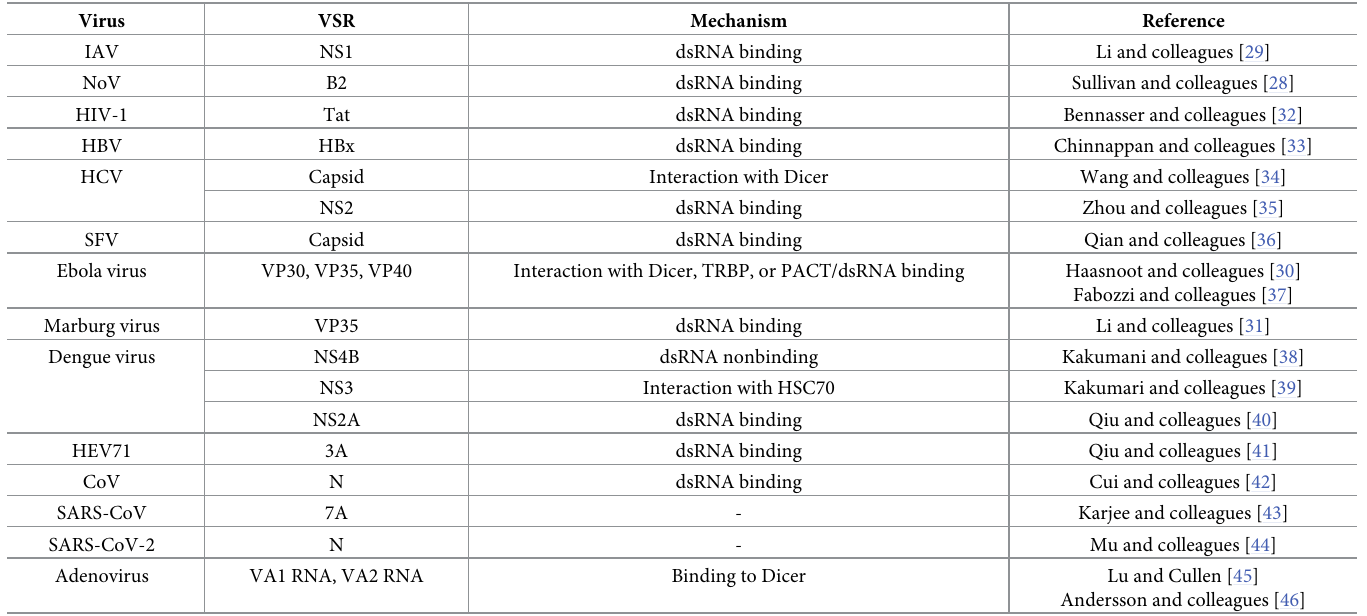
Table 2. List of representative VSRs in mammalian